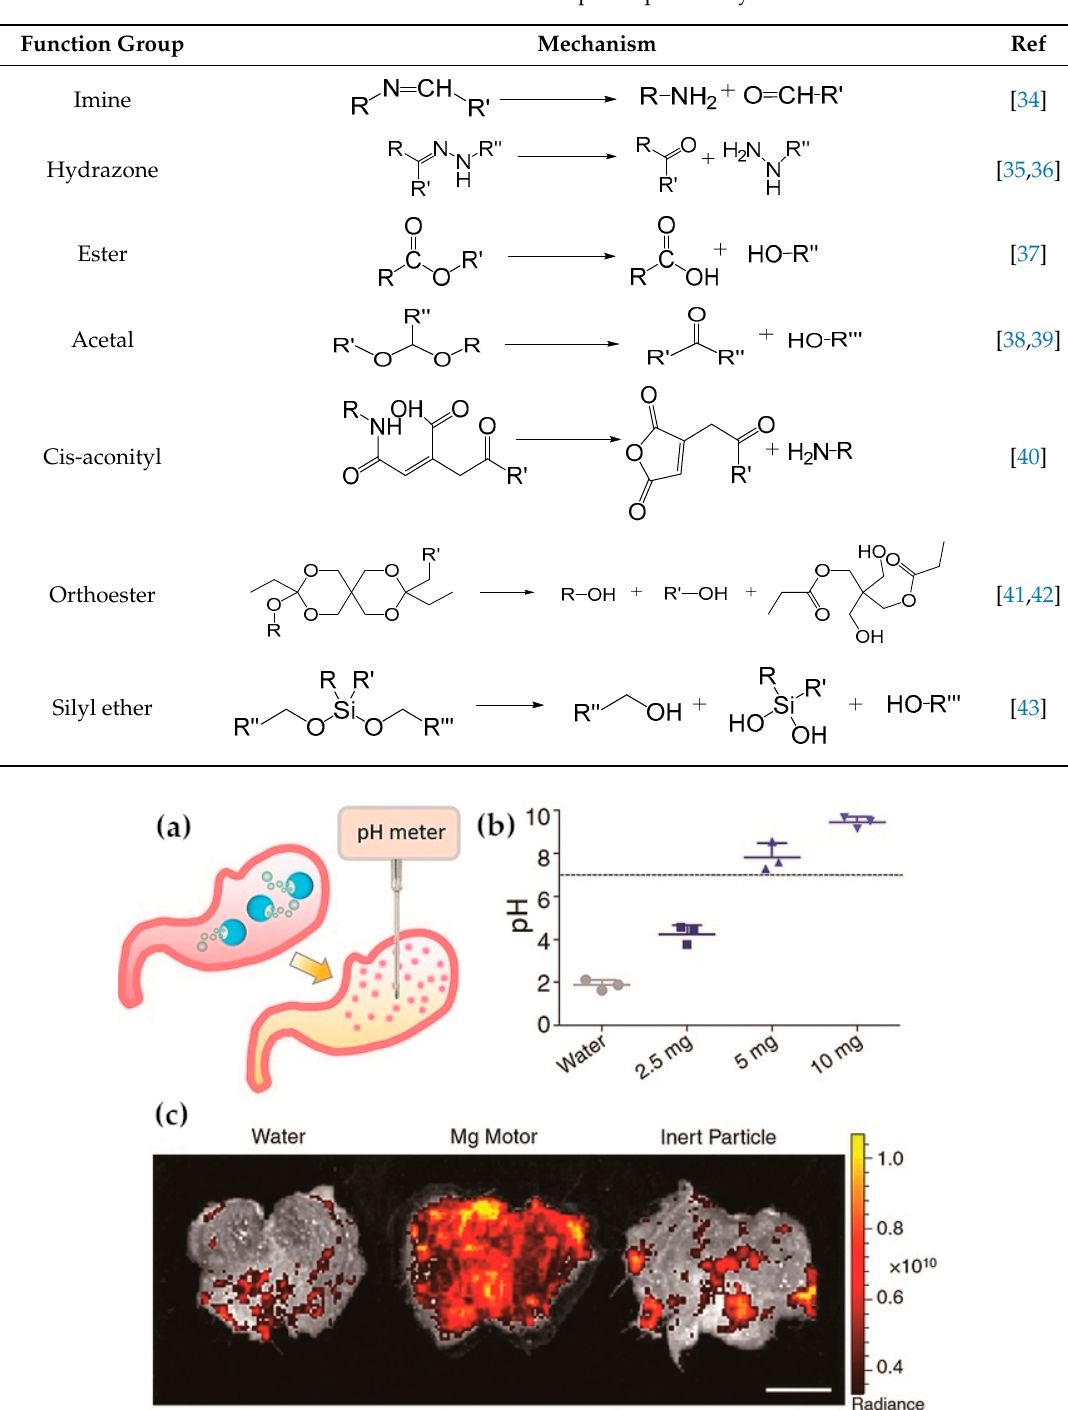
Table 1. Chemical structures for pH responsive systems.